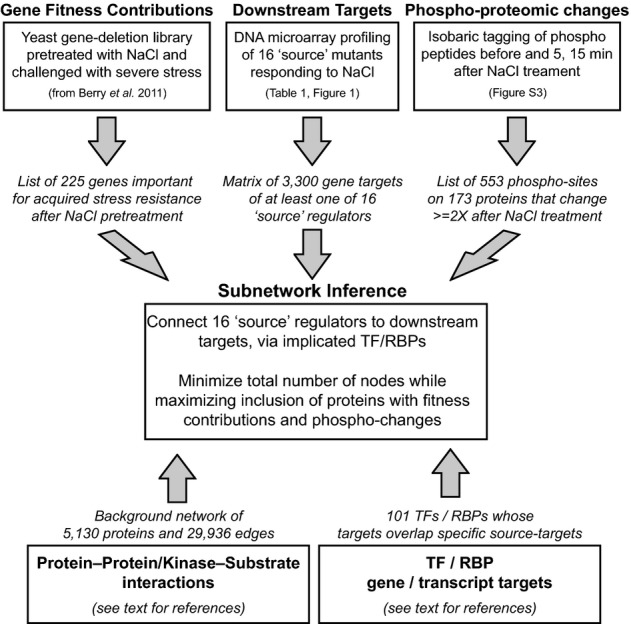
Overview of the experimental data collection and analysis to generate IP inputSee text for details.